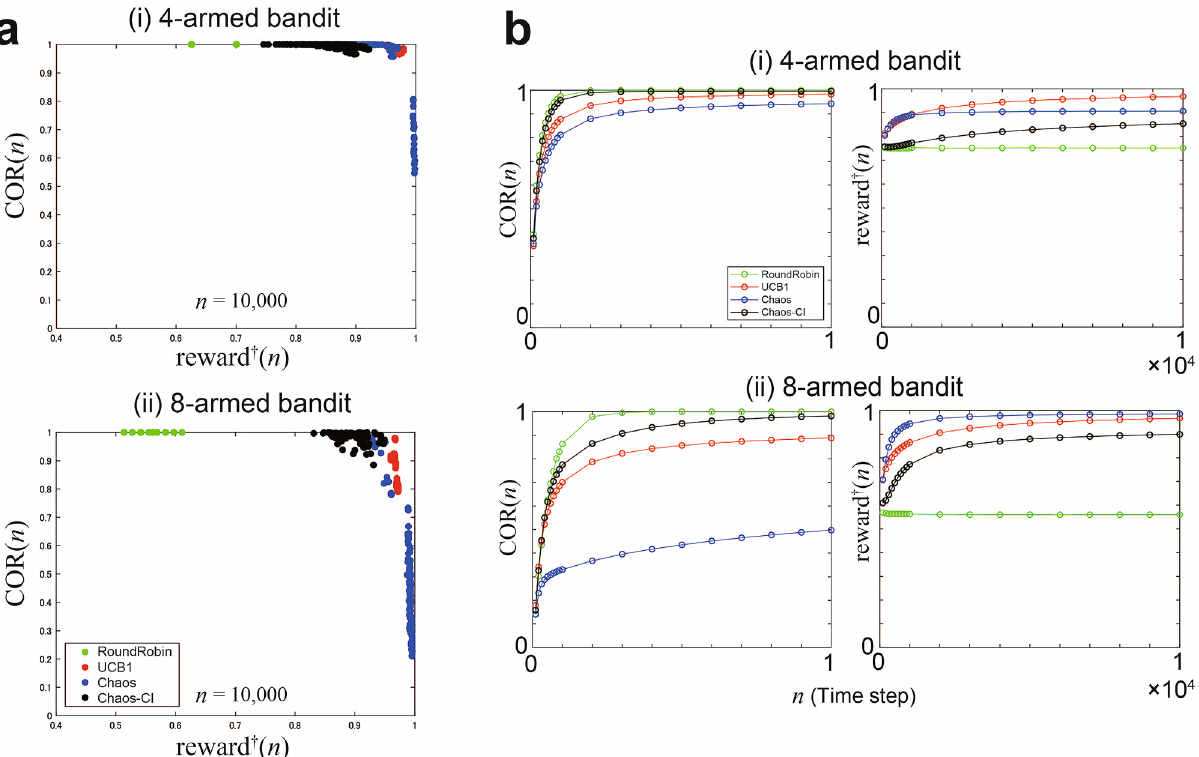
Figure 3. Metrics over the whole reward environments prepared. ( a ) Each scatter plot represents a normalized reward reward † ( n ) and correct order rate COR ( n ) at time step n ( reward † ( 10,000 ) , COR ν ( 10,000 )) . The more the scatter plot is at the top of the graph, the higher the order ν estimation accuracy is, and the more the scatter plot is at the right, the greater the obtained reward is. ( b ) Time evolution of the average value of each metric over the whole ensemble of reward environments ( 1